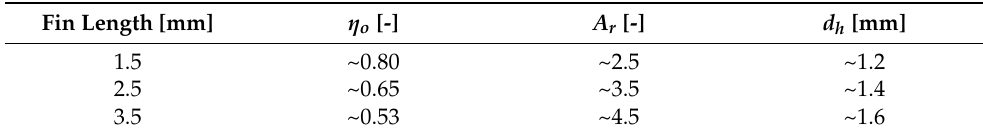
Table 3. Analyzed fluid surface geometries.